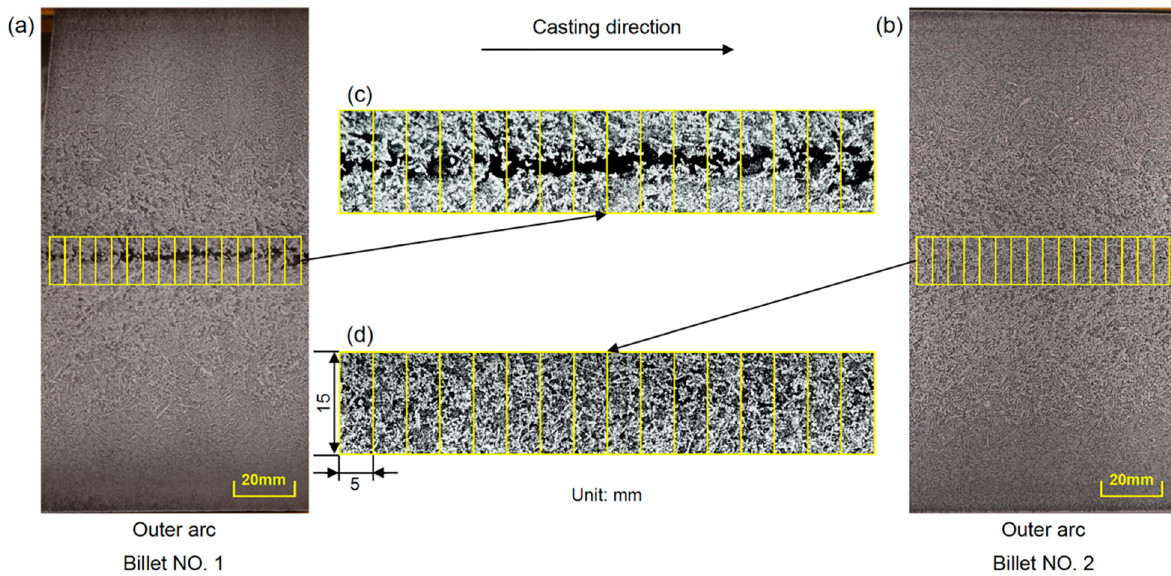
Figure 2. Selected analysis areas and the corresponding solidification structure of two billet samples. ( a , b ) show the solidification structure of the selected vertical sections of billet No. 1and 2. ( c , d ) show the selected analysis areas along the casting direction on the central vertical sections. The size of each analysis area is 5 mm × 15 mm.